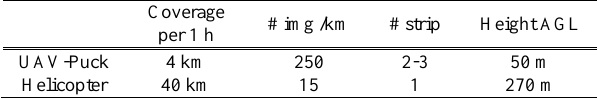
Table 7: Flight parameters for corridor of 200 m